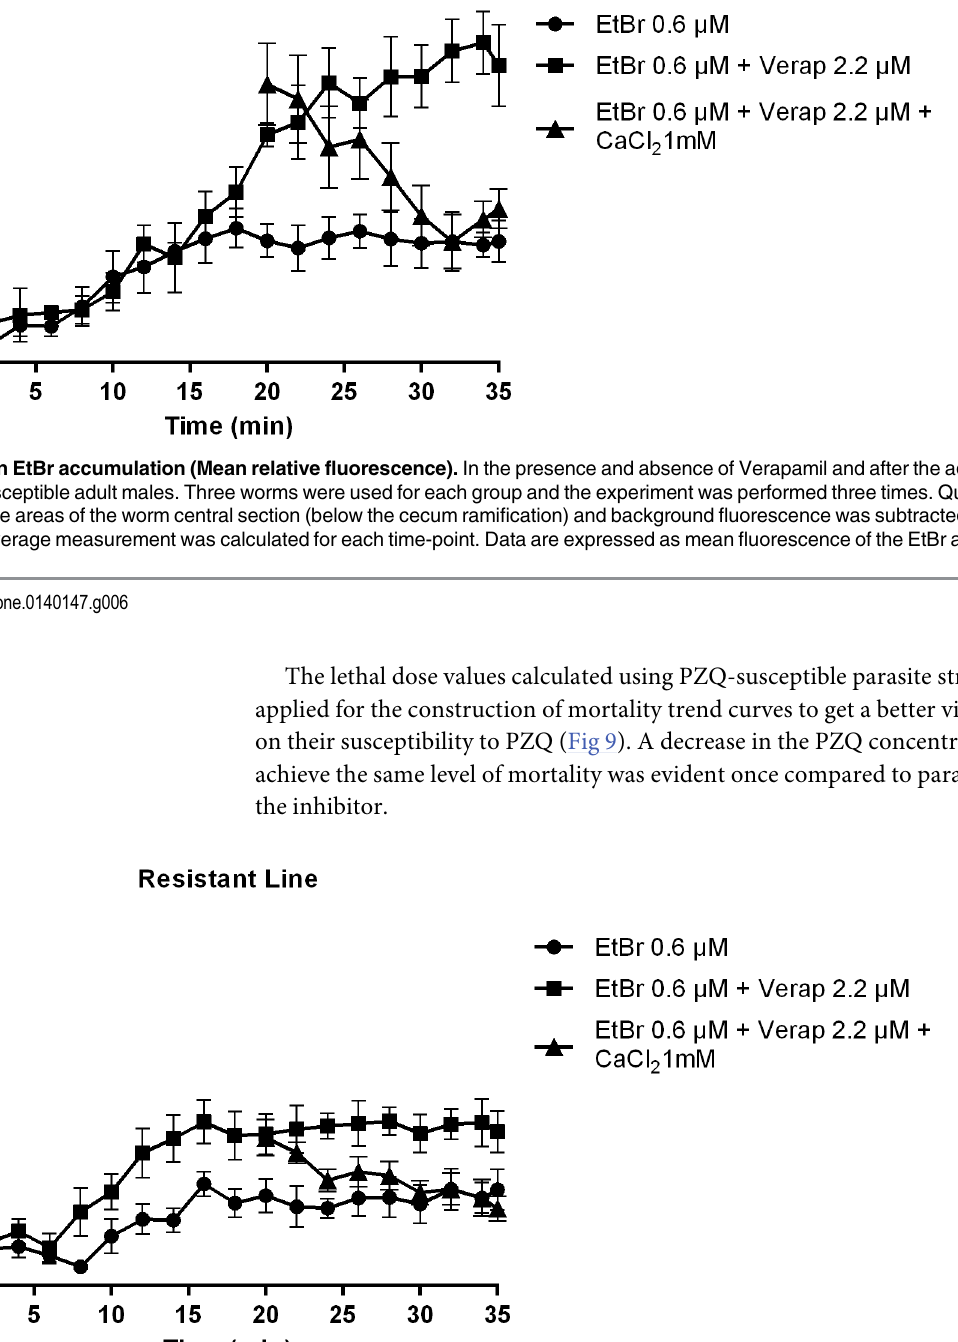
Fig 7. Variation in EtBr accumulation (Mean relative fluorescence). In the presence and absence of Verapamil and after CaCl 2 addition in S . mansoni PZQ-resistant adult males. Three worms were used for each group and the experiment was performed three times. Quantification measurements were made in three areas of the worm central section (below the cecum ramification) and background fluorescence was subtracted for each parasite at each time-point. The average measurement was calculated for each time-point. Data are expressed as mean fluorescence of the EtBr accumulated intracellularly over